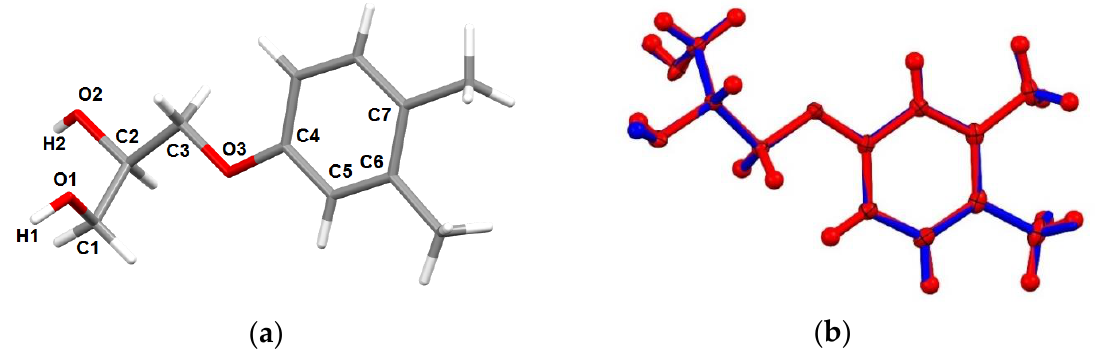
Figure 8. ( a ) Geometry of the molecules in ( R )- 1 crystals. ( b ) Conditional superposition of Figure8. ( a ) Geometry ofthe molecules in ( R )- 1 crystals. ( b ) Conditional superpositionof R -enantiomers R -enantiomers in ( R )- 1 (blue) and α - rac - 1 crystals (red). in ( R )- 1 (blue) and α - rac - 1 crystals